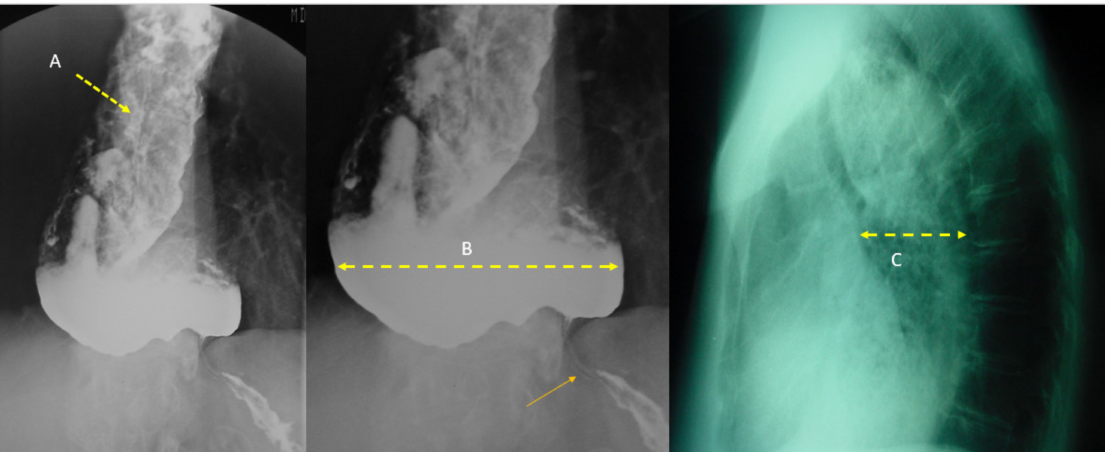
Figure 1. A 52-year-old male presented with marked signs of dehydration and malnutrition after a 20-year history of dysphagia, initially for liquids and later for solids. To overcome difficulty in swallowing, the patient used various maneuvers such as stretching the neck, raising the arms, taking a deep breath, and/or drinking water. In the weeks before his admission, he indicated experiencing excess coughing at night, with regurgitated food remnants found on the pillow the following day. The patient was diagnosed with achalasia and underwent Heller myotomy after prehabilitation with fluid and electrolyte replacement and parenteral nutrition. ( A ) Barium esophagogram with repletion defects corresponding to food detritus and saliva indicated (yellow arrow), ( B ) Marked increase in esophageal diameter (yellow arrow) that more closely resembles a colon (yellow arrow) in barium esophagogram. The sharp end is reminiscent of a mouse tail (orange arrow). ( C ) Chest X-ray showing widening of the mediastinum simulating false cardiomegaly in the lateral projection (yellow arrow. Courtesy of Dr. Rubio, M.D. Department of Radiology University Hospital, San Jorge, Huesca (Arag ó